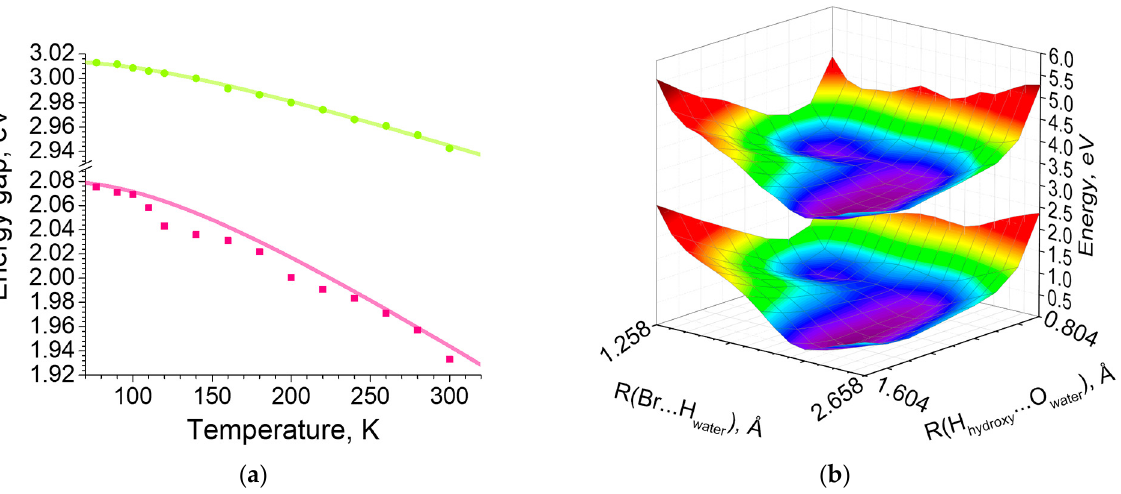
Figure 5. ( a ) Temperature dependence of the bandgap energies of 1 , and ( b ) calculated potential energy surfaces of the ground and excited states of 1 along the R(Br…H water ) and R(H hydroxy …O water ) distance changing.